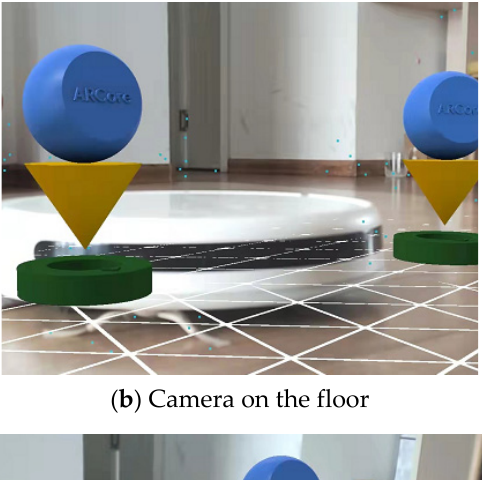
10 of 13 Table 2. Comparison of plane recognition results. Recognized Planes